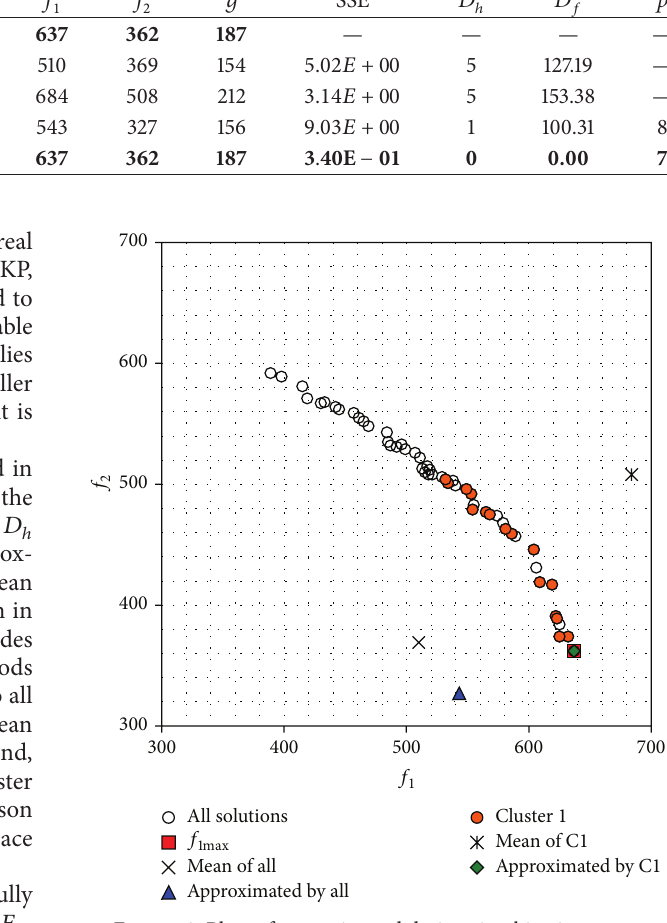
Figure 8: Plots of approximated designs in objective